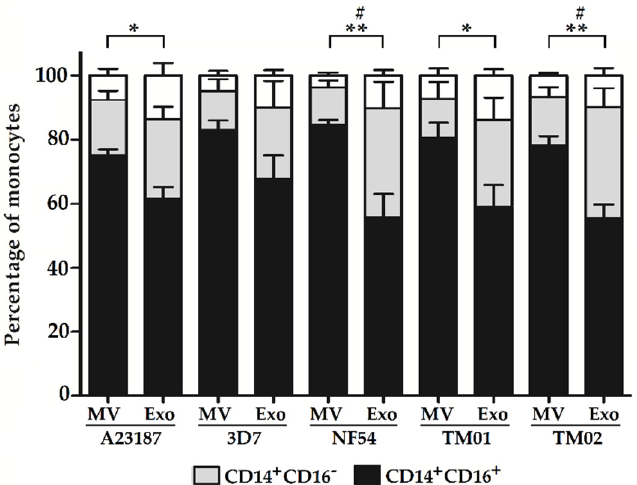
Figure 3. The percentage of monocyte subsets after EV stimulation: CD14 + CD16 + monocyte (black bar), CD14 + CD16 − monocyte (gray bar), CD14 dim CD16+ monocyte, and CD14 − CD16 − cells (white bar). The data presented as mean ± SEM from 4 independent experiments. * p < 0.05 and ** p < 0.01 between Pf -MV and Pf -Exo stimulation in the CD14 + CD16 + subset and # p < 0.05 between Pf- MV and Pf -Exo stimulation in the CD14 + CD16 − subset.